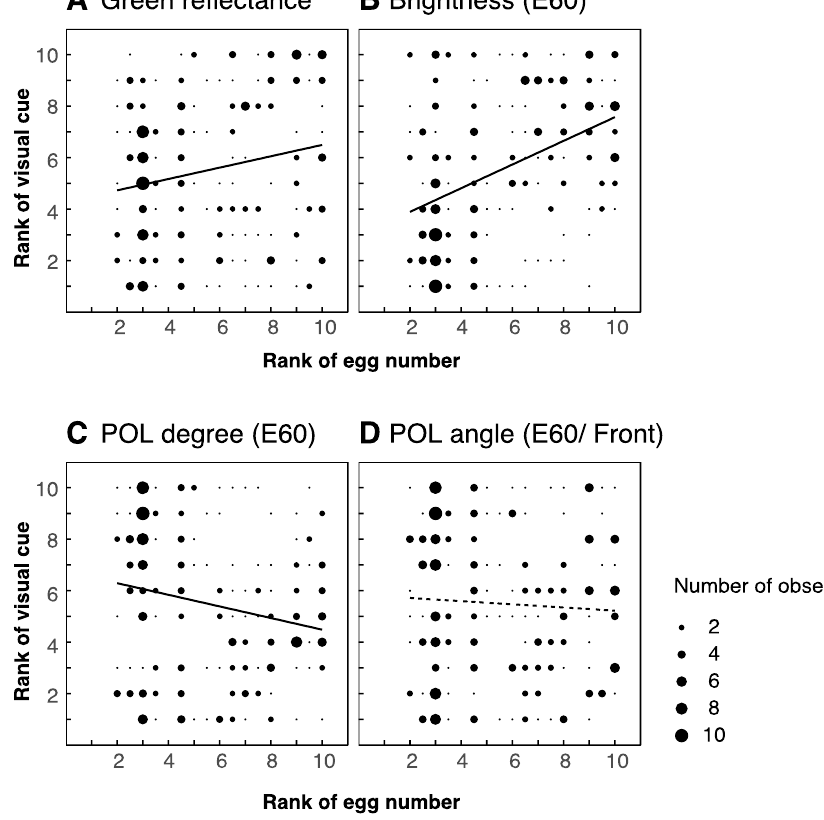
Figure 5. Correlation between reflective features of leaves and proportion of eggs laid.